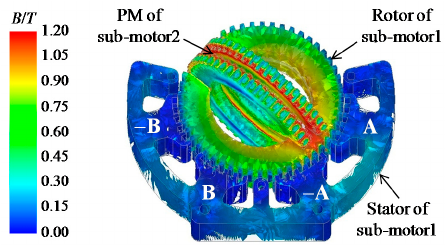
Figure 3. Magnetic field distribution produced by the PM of sub-motor2.